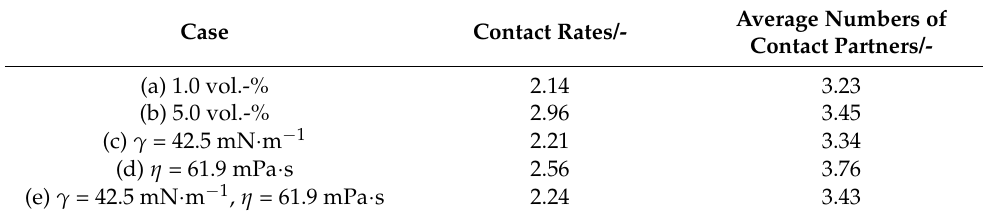
Table 5. Contact rate and average number of contact partners for the five simulation cases.